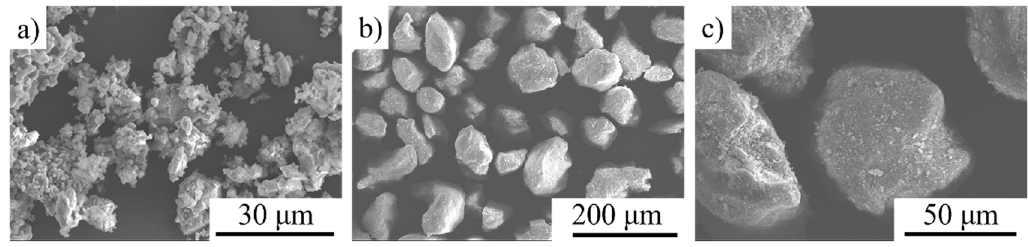
Figure 3. SEM micrographs of feed powder: ( a ) before granulation; ( b , c ) after granulation.